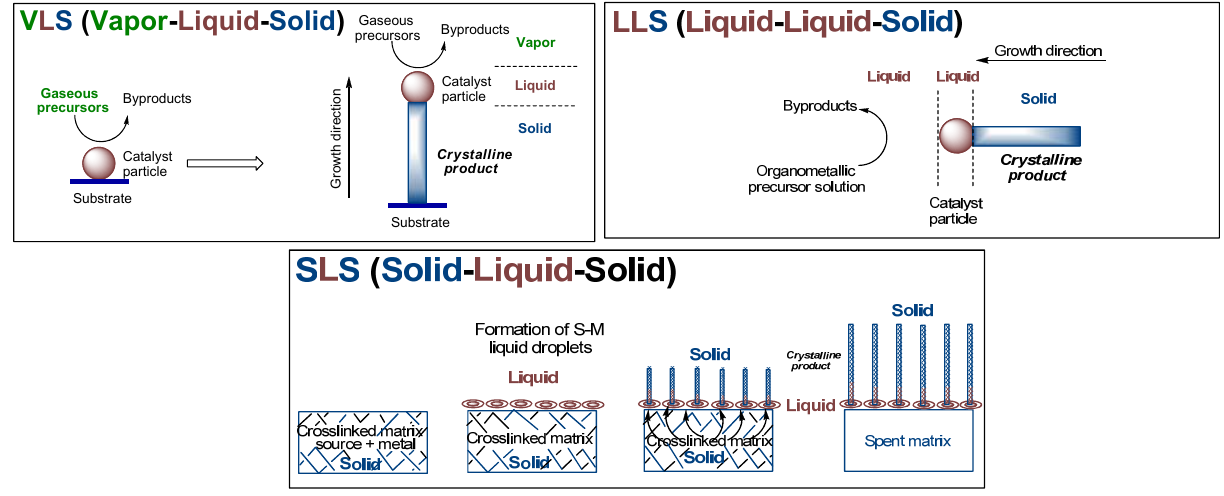
Figure 2. Schematic representations of the Vapor-Liquid-Solid (VLS), Liquid-Liquid- Solid (LLS) and Solid-Liquid-Solid (SLS) mechanisms. VLS and LLS mechanisms, adapted from Ref. [45] with permission from The American Association for Advancement of Science, and SLS mechanism, adapted from Ref. [47] with permission from